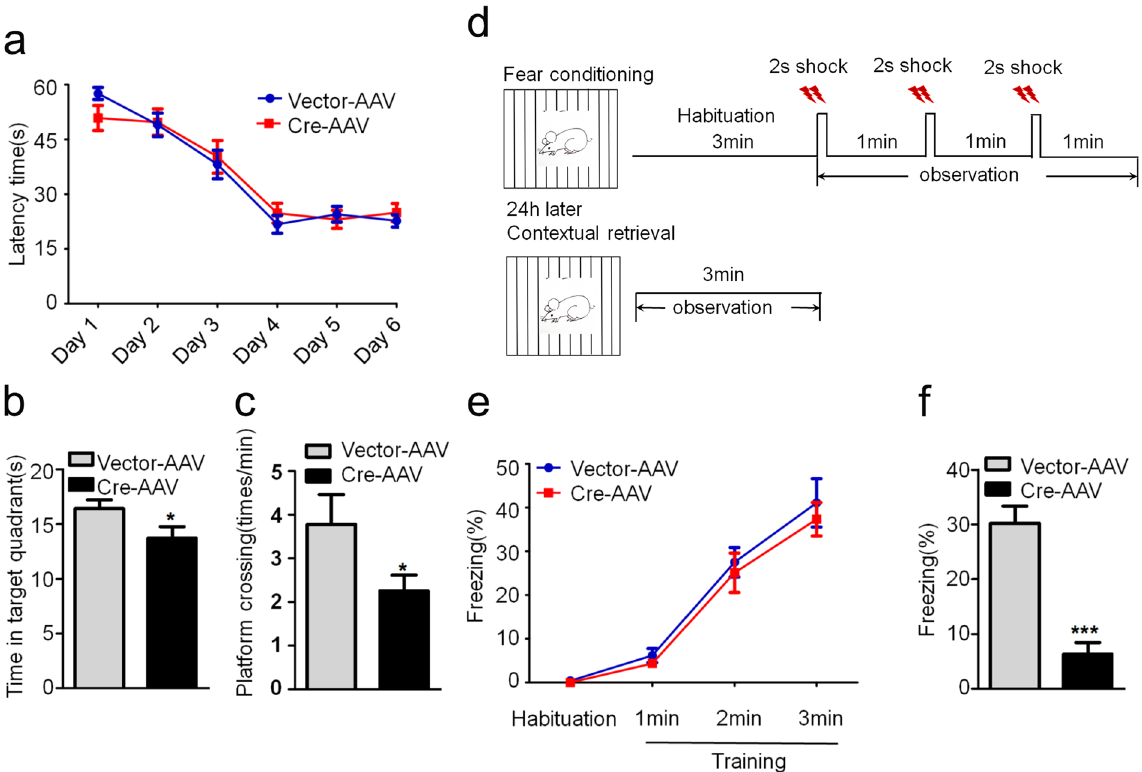
Figure 2. GSK-3 β deletion in DG induces spatial and fear memory deficits. ( a ) GSK-3 β deletion in DG excitatory neurons does not change the latency to find the hidden platform during 6 days Morris water maze (MWM) training. ( b,c ) GSK-3 β deletion induces memory deficits shown by the decreased time in previous target quadrant and the crossings in the platform region measured at day 8 by removed the platform (Vector, n = 10; Cre, n = 8). ( d ) The schematic representation of contextual fear memory test. ( e ) No change of freezing time was detected in GSK-3 β deletion during the contextual fear training test. ( f ) The percentage time of freezing was remarkably decreased during the contextual memory test carried out in the next day (Vector, n = 10; Cre, n = 8). Data were presented as mean ± s.e.m. Two–way repeated-measures ANOVA with Huynh- Feldt-Lecoutre correction for panels (a) and (e); unpaired t test for panels (b, c, and f). * P < 0.05, *** P < 0.001 versus Vector. The absence of asterix indicates that the difference is not